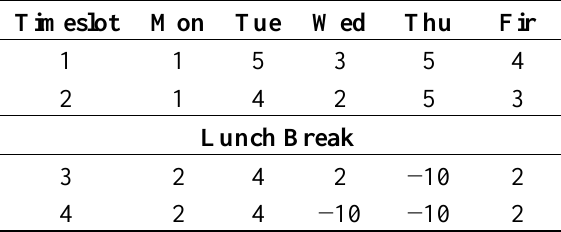
Table 1. Preference timeslot